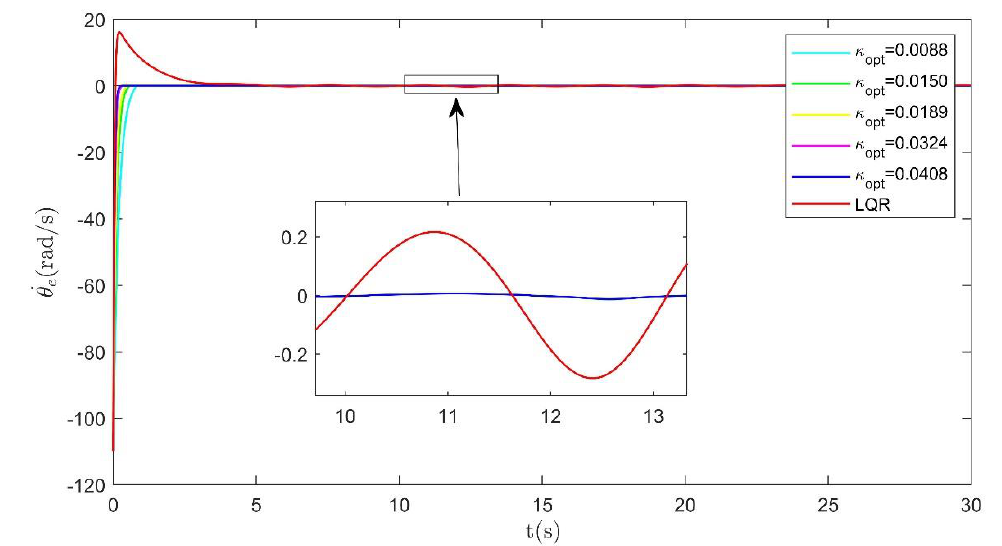
Figure 8. The sinusoidal tracking speed error curve of the electric tail reduction system.